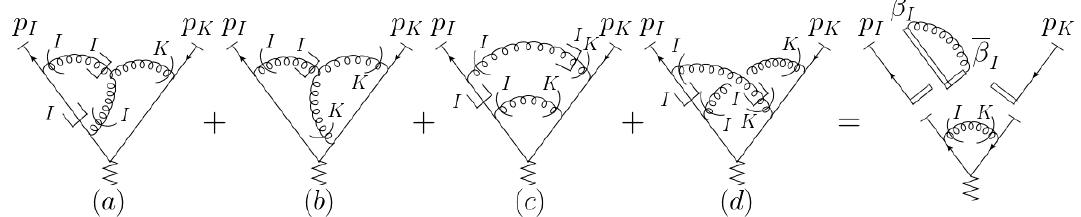
Figure 37. The graphic contributions to P